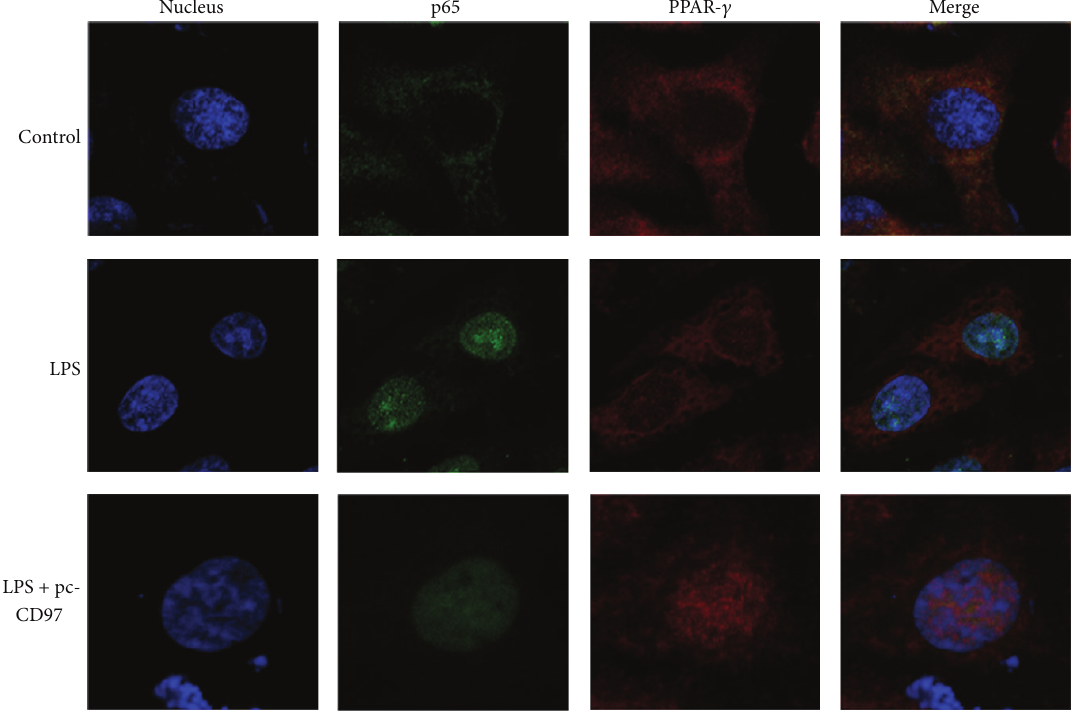
Figure 4: Confocal imaging of p65 and PPAR- 𝛾 in macrophages. Macrophages were treated with LPS (40ng/mL) or transfected with CD97 overexpression plasmid and stimulated with LPS (40ng/mL) for 24h. Confocal imaging of p65 and PPAR- 𝛾 was performed. When treated with LPS, p65 displayed nuclear translocation while CD97 overexpression inhibited it but strengthened PPAR- 𝛾 nuclear translocation. The green signal represented p65 and red signal depicted PPAR- 𝛾